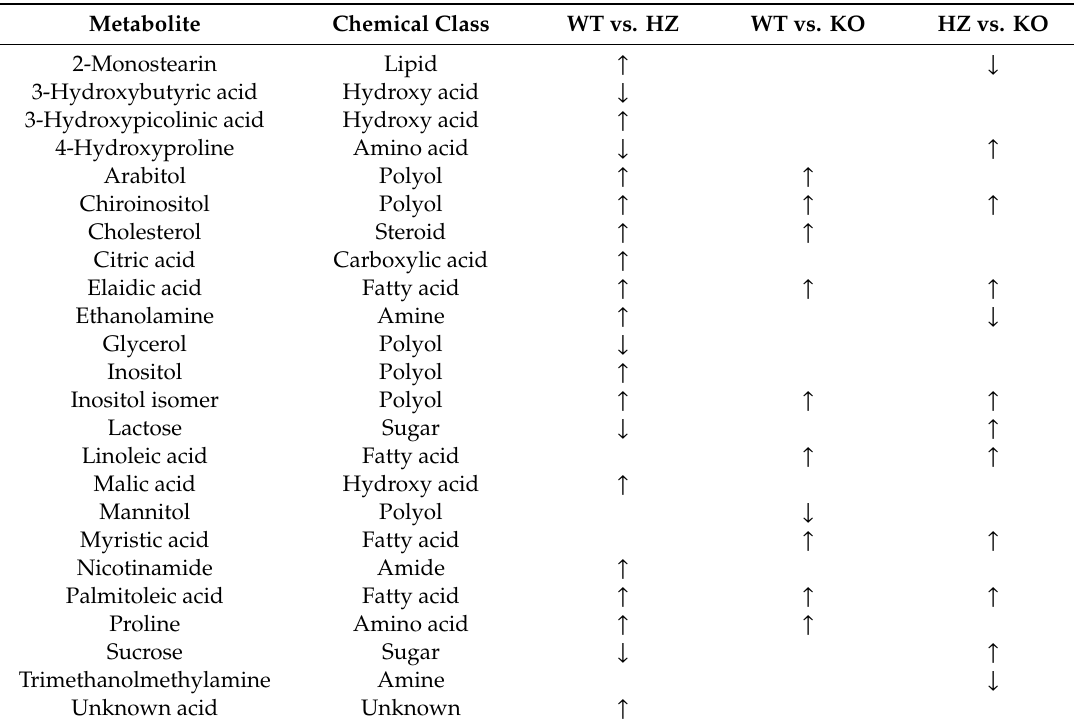
Table 2. PLS-DA most important metabolites (VIP = Variable Importance in the Projection; VIP score > 1) and the relative abundance di ff erences. ↑ more abundant in the first class compared with the second; ↓ less abundant in the first class compared with the